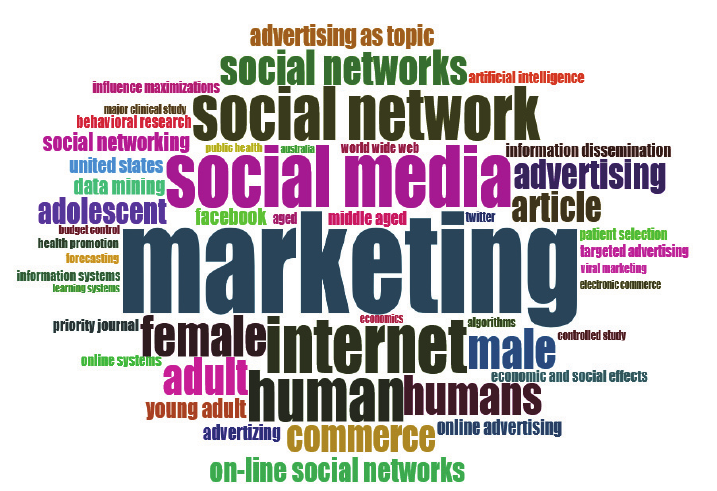
Fig. 3. The frequency of the keywords used in different advertising in social network studies